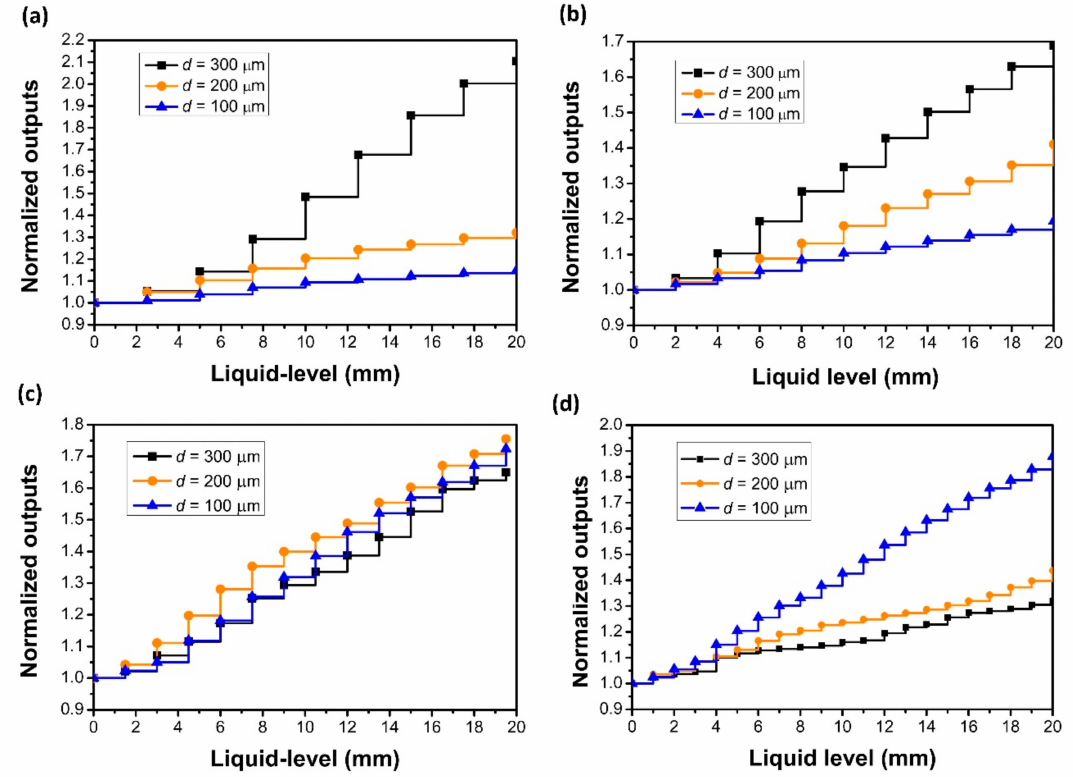
Figure 4. Sensing performances for POF probes with different V-groove pitches and depths, where the V-groove pitches are 2.5 ( a ), 2.0 ( b ), 1.5 ( c ), and 1.0 mm ( d ), and the V-groove depths are about 100,